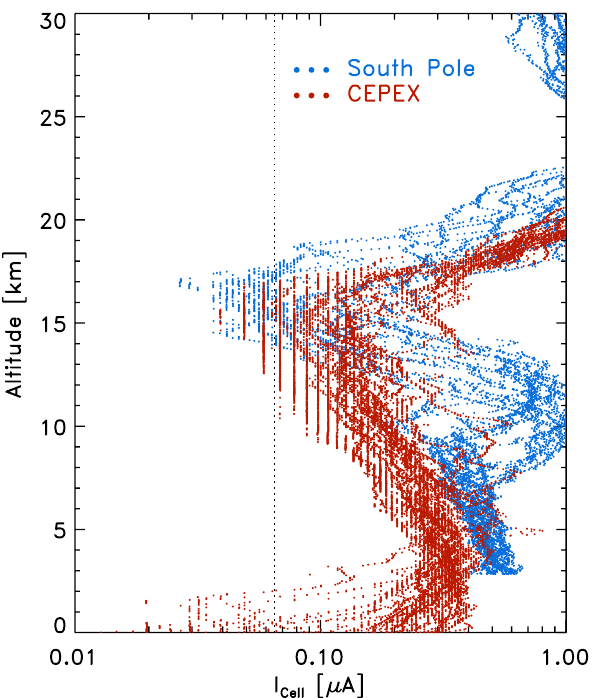
Fig. 7. Distribution of ozone observations at 200hPa at Fiji, San Cristobal, Samoa, and Tahiti for all soundings between 1995 and 2008. Original data that used background currents larger than 0.028µA shown in blue diamonds (779 soundings), original data that used background currents less than 0.028µA shown in green dots (621 soundings). Shown in red stars are all data reprocessed using the modified background, disregarding the measured back- ground